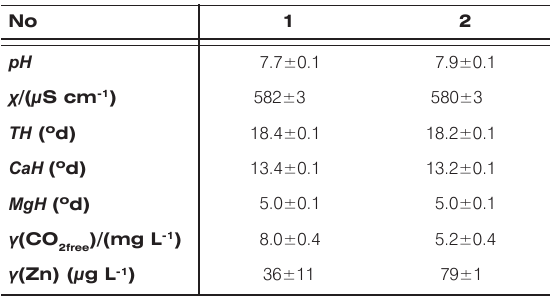
Maribor waterworks.